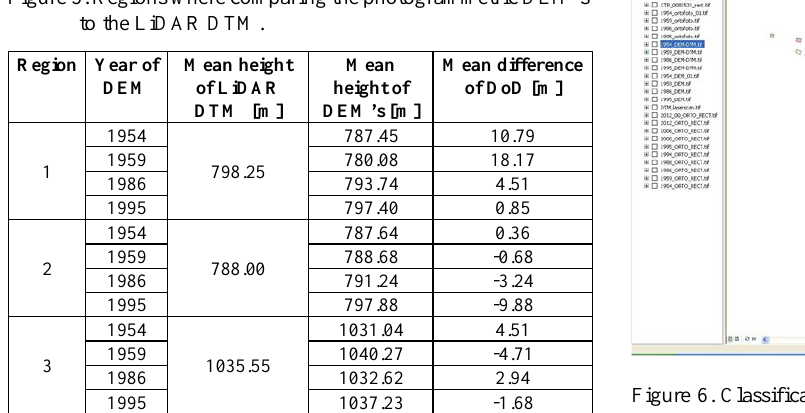
Table 6. Comparison between the average heights of a reference LiDAR DTM and photogrammetric DEM’s.